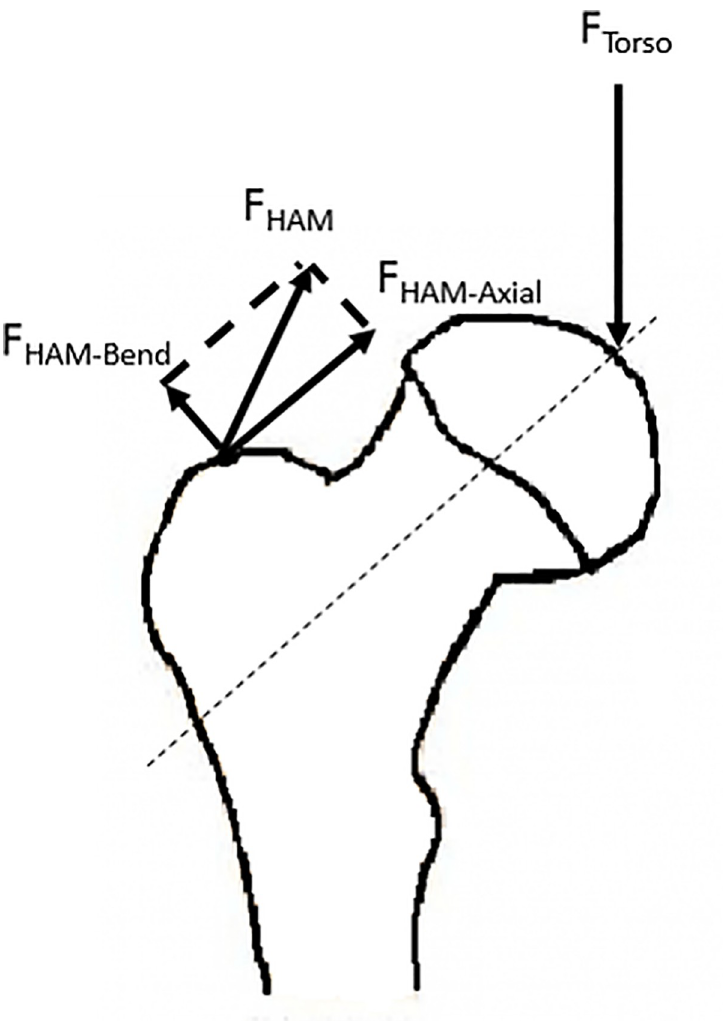
compression for both superior and inferior surfaces; the component perpendicular to the femoral neck long axis (F HAM-Bend ) bent the femoral neck in the superior